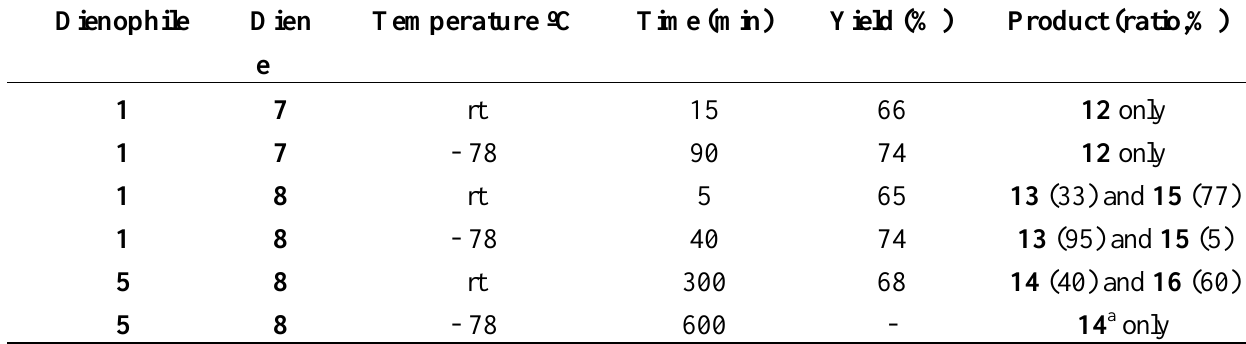
Table 3. Results obtained in reactions between enones 1 , 5 and furans 7, 8